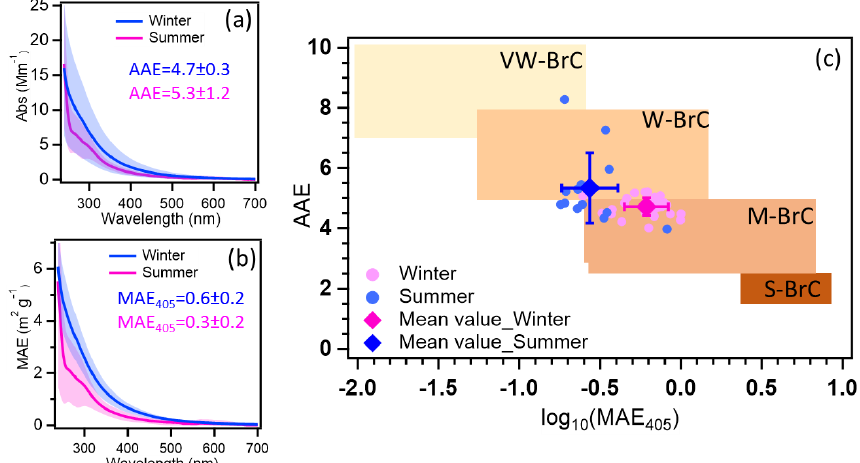
Figure 2. The average Abs (a) and MAE (b) of MS-BrC in winter (blue) and summer (pink). (c) Graphical representation of optical-based BrC classes in AAE-log 10 (MAE 405 ) space with summer and winter data (Saleh, 2020; Hettiyadura et al., 2021). VW-BrC, W-BrC, M-BrC, and S-BrC, are very weakly absorbing, weakly absorbing, moderately absorbing, and strongly absorbing BrC. AAE reported in this work is calculated for a wavelength range of 300–450nm. Please note that the small shoulder peak at ∼ 300nm for the average summer sample (a, b) is most likely due to some contamination e.g. from the filter. However, it only occurred in a few filter samples and does not affect our main